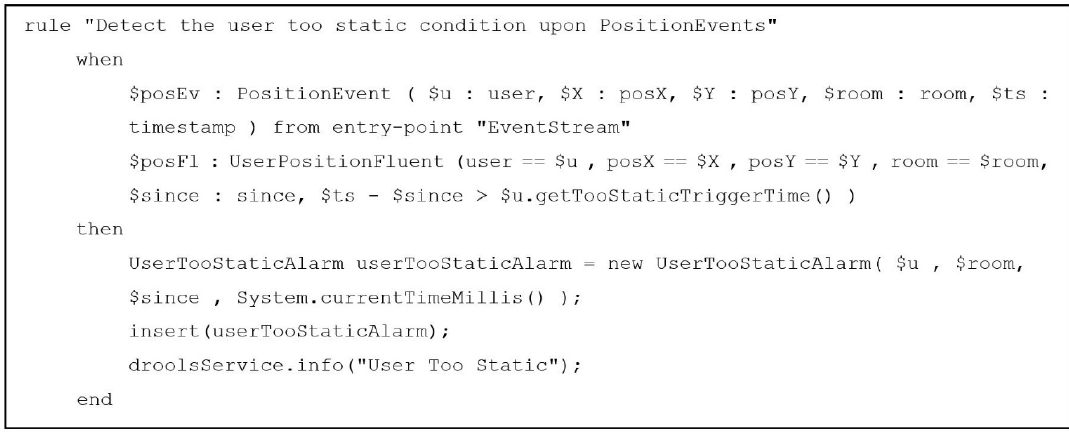
Figure 10. Example of a Drool rule present in the AI module.